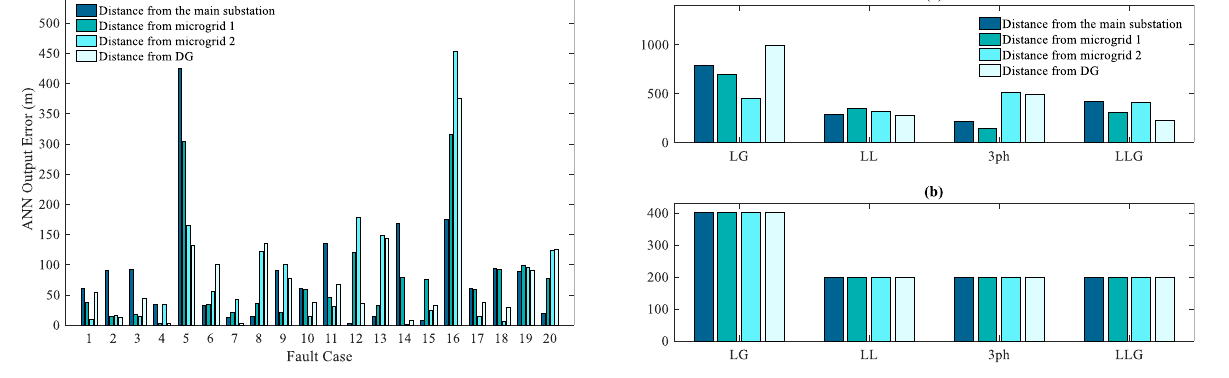
Fig. 8 Output MAE values for different fault types for 424 test cases. a for ANN outputs b for KNN outputs